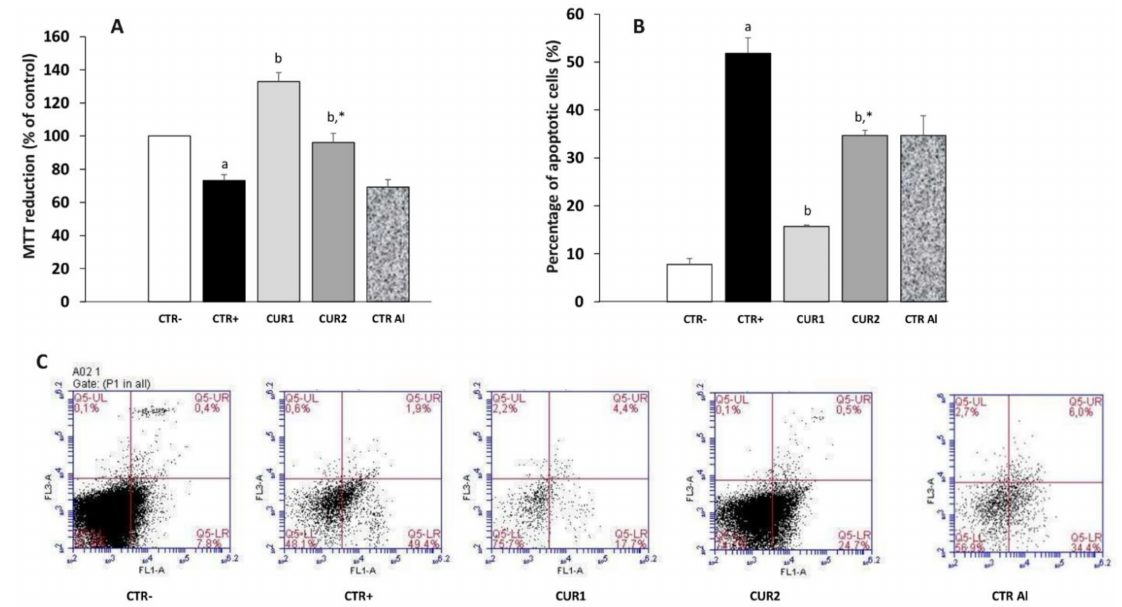
Figure 5. Effect of co and post-treatment of curcumin on the hippocampus cell viability and apoptosis on rat model of AD induced by chronic administration of AlCl 3 : ( A ) effect on the percentage of cell viability by MTT test; ( B ) effect on the percentage of apoptosis by annexinV-FITC/PI staining; ( C ) apoptosis was detected by cytometry using the Annexin V-FITC/PI Apoptosis Detection kit (viable cells are negative to both probes; apoptotic cells are Annexin positive). Values are mean ± SEM. Note: CTR − : negative control group; CTR+: positive control group (treated by aluminum chloride (AlCl 3 )); CUR1: co-treatment with curcumin; CUR2: post-treatment with curcumin; CTRAl: exposed to AlCl 3 for 90 days and survive 60 days without any treatment; a: p < 0.05 as compared to CTR − group; b: p < 0.05 as compared to CTR+ group; *: p < 0.05 as compared to CTRAl group, repeated measures two-way ANOVA followed by Tukey’s test for multiple comparisons.